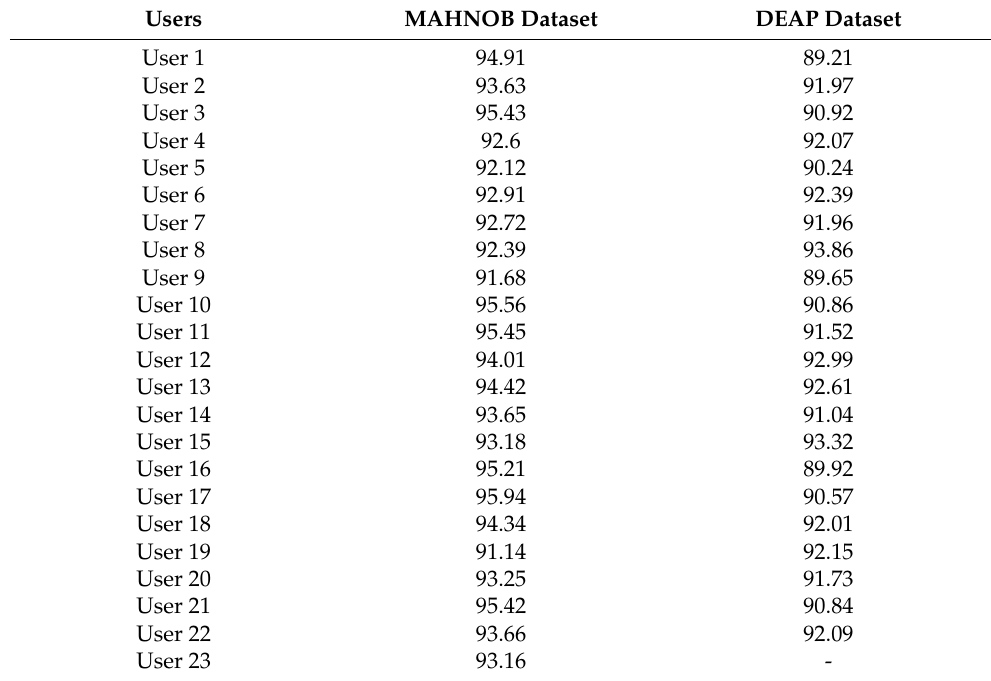
Table 5. Results of fusion of EEG and facial video clips using DCCA in terms of accuracy